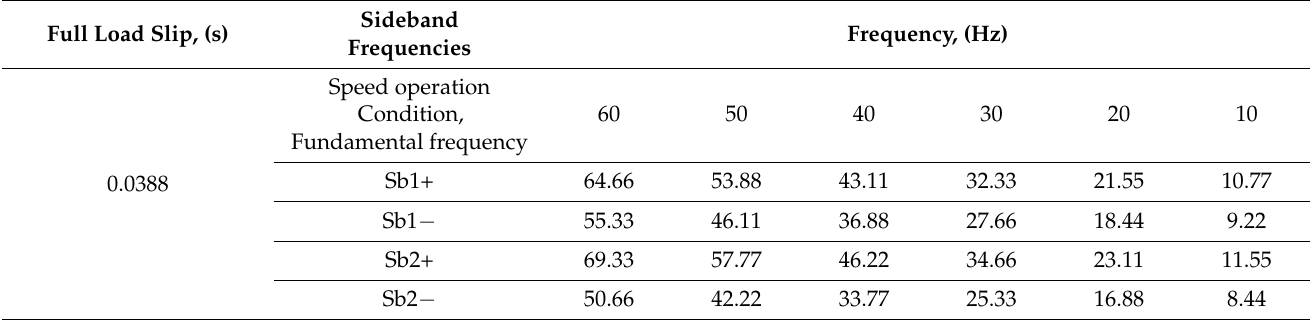
Figure 13. FFT analysis of current signal measurement of motor line current of phase A, frequency spectrum, and periodogram at 10 Hz speed operation. Table 4. BRB sbf for each speed operation condition at